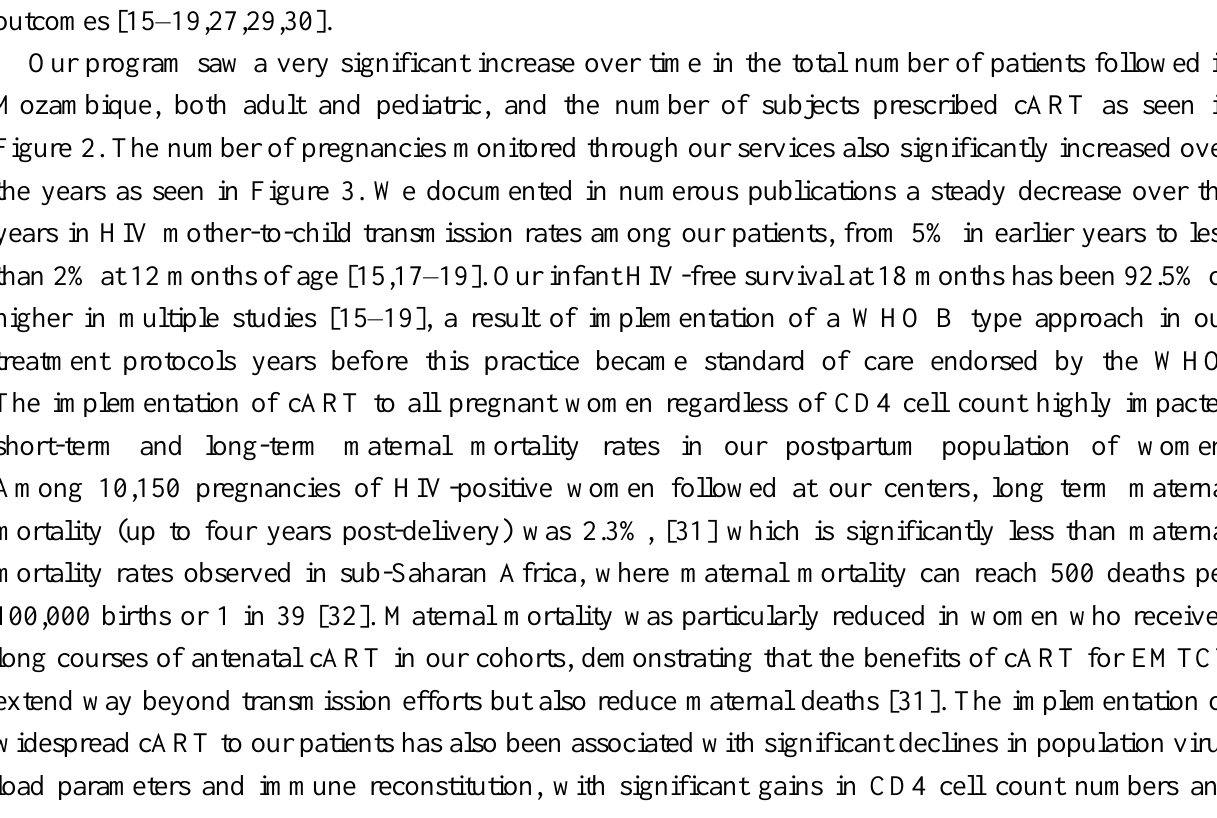
Figure 3. HIV+ pregnancies and HIV-exposed infants followed in DREAM centers in Mozambique over